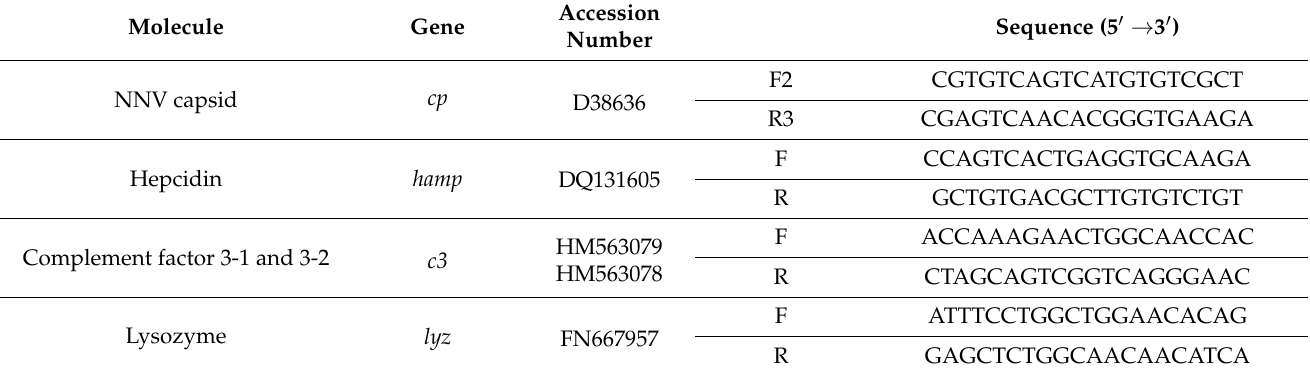
Table 1. Gene accession numbers and primer sequences used for gene expression